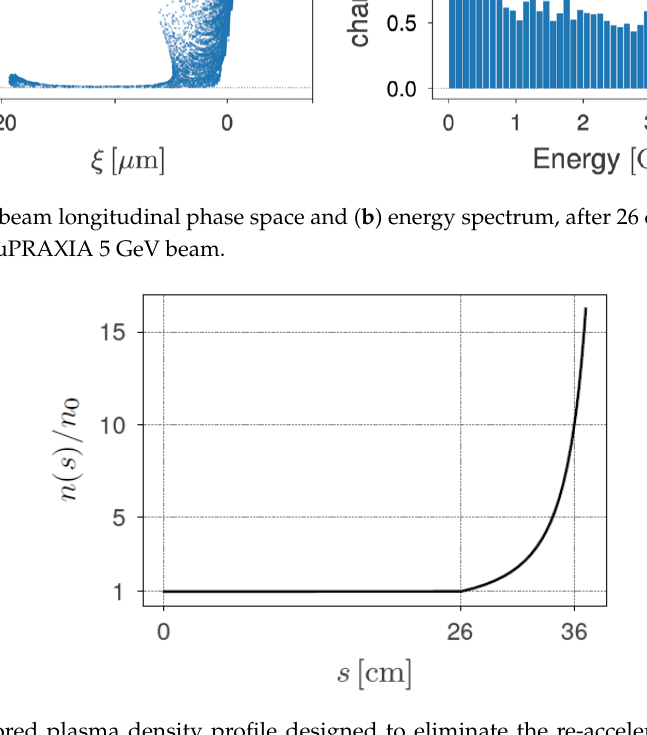
Figure 5. ( a ) The beam longitudinal phase space and ( b ) energy spectrum, after 26 cm propagation in plasma, for the EuPRAXIA 5 GeV beam.